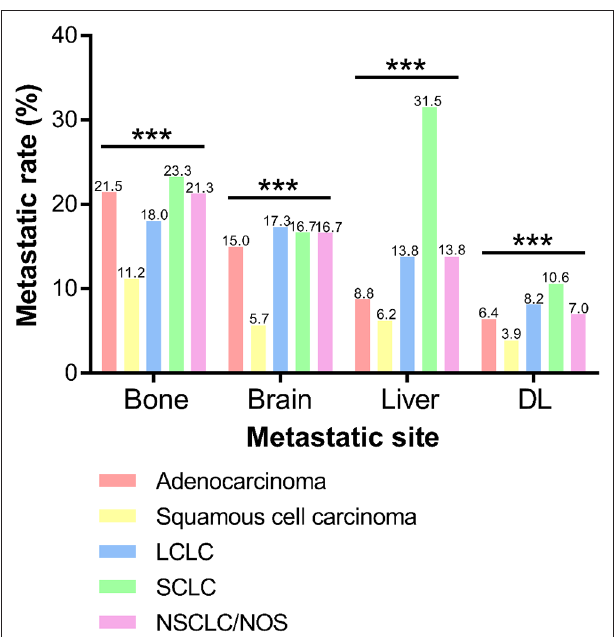
FIGURE 2 | Frequencies of extrathoracic metastatic organs according to different histological types. DL, distant lymph node. (*** P <